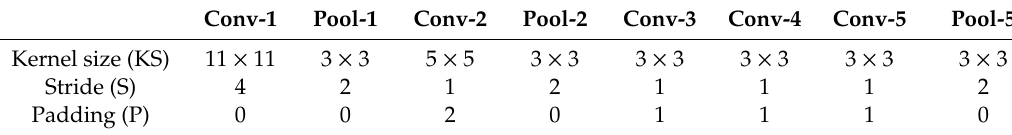
Figure 2. Architecture of AlexNet. Table 1. Parameters for each layer of AlexNet.